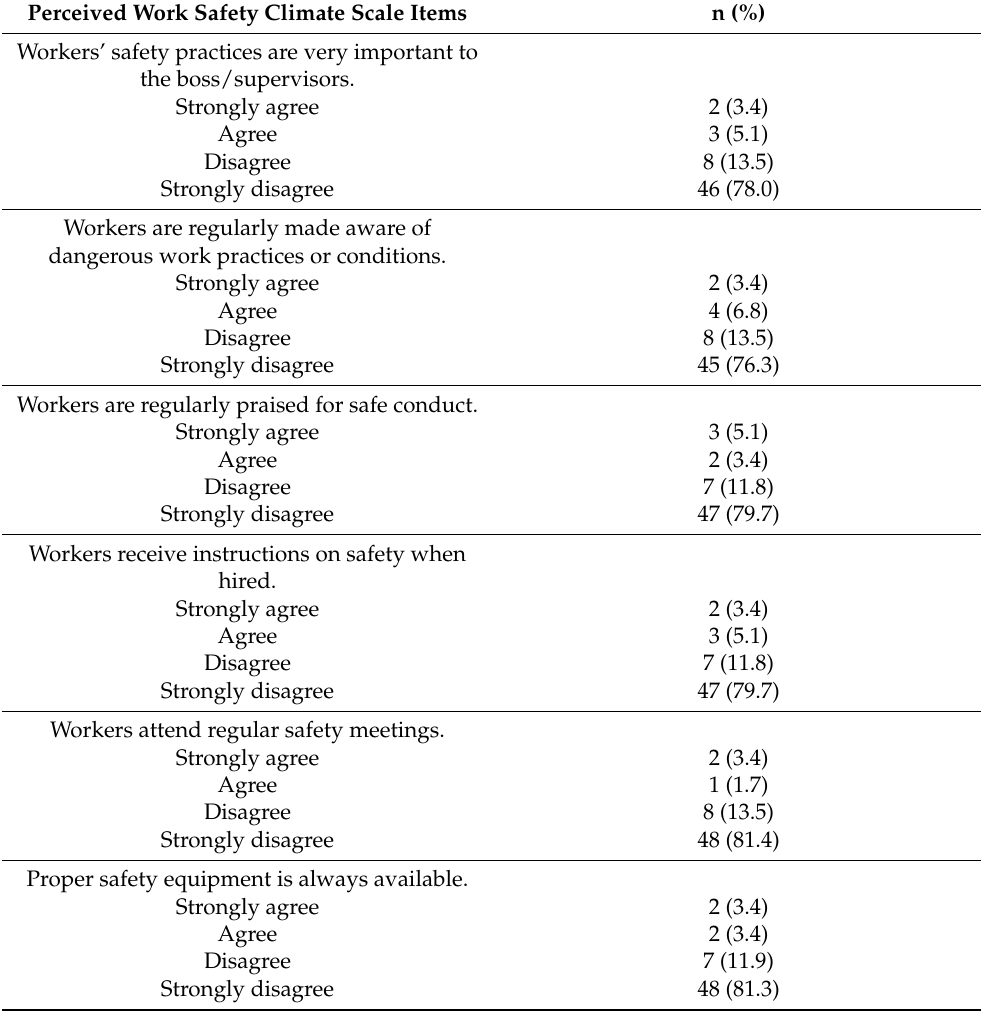
Table 6. Perceived Work Safety Climate, Latinx Women in Farmworker Families Employed in the Past Year at Follow-Up 5 Questionnaire, North Carolina (N =